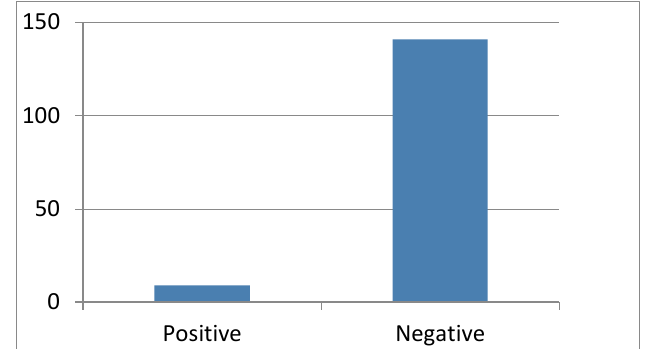
Figure 1 . The result of Aspergillus growth on culture